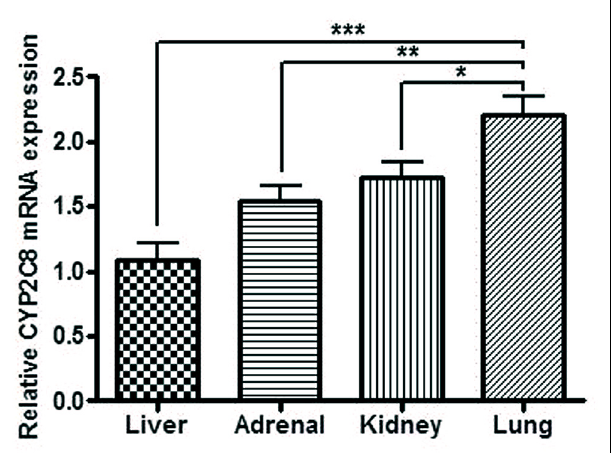
FIGURE 5 | Relative CYP2C8 mRNA expression in liver, adrenal, kidney, and lung from human fetuses ( n = 60). CYP2C8 mRNA expression was detected in all of the extra-hepatic tissue samples with significantly higher expression in lung compared to kidney, adrenal and liver. * p < 0.05, ** p < 0.01, *** p <